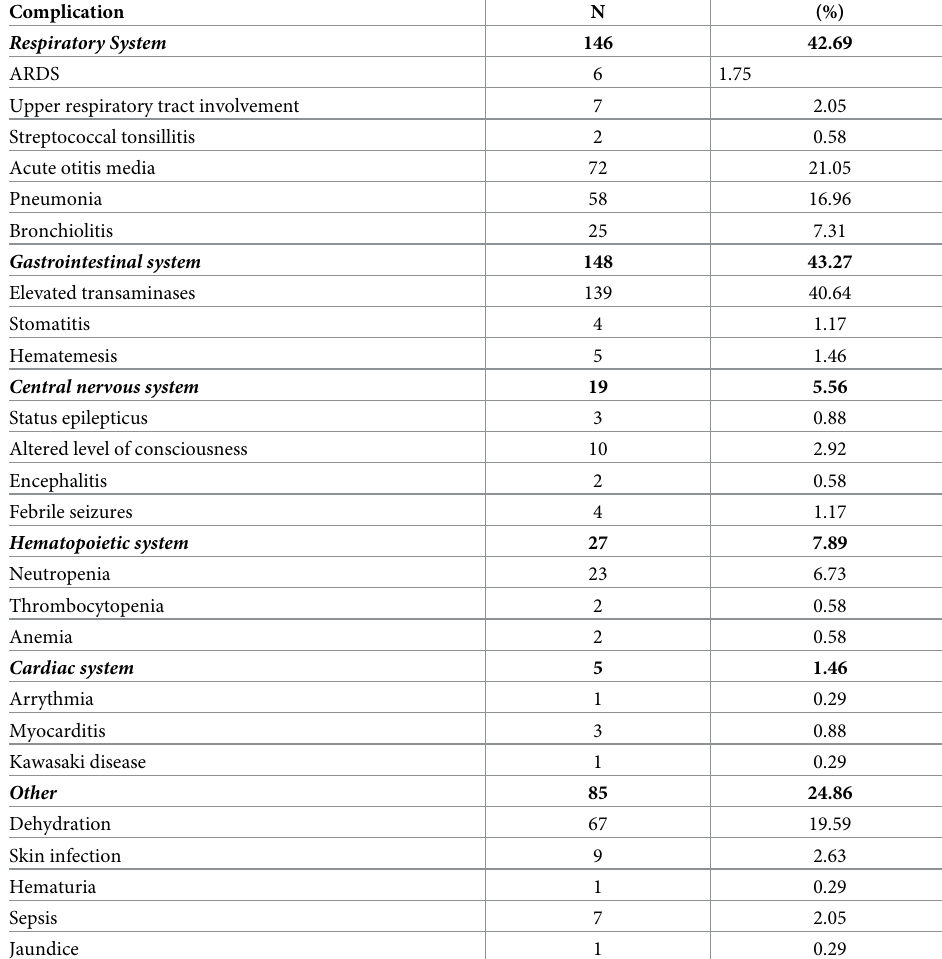
Table 3. Complications in 342 hospitalized children with measles,